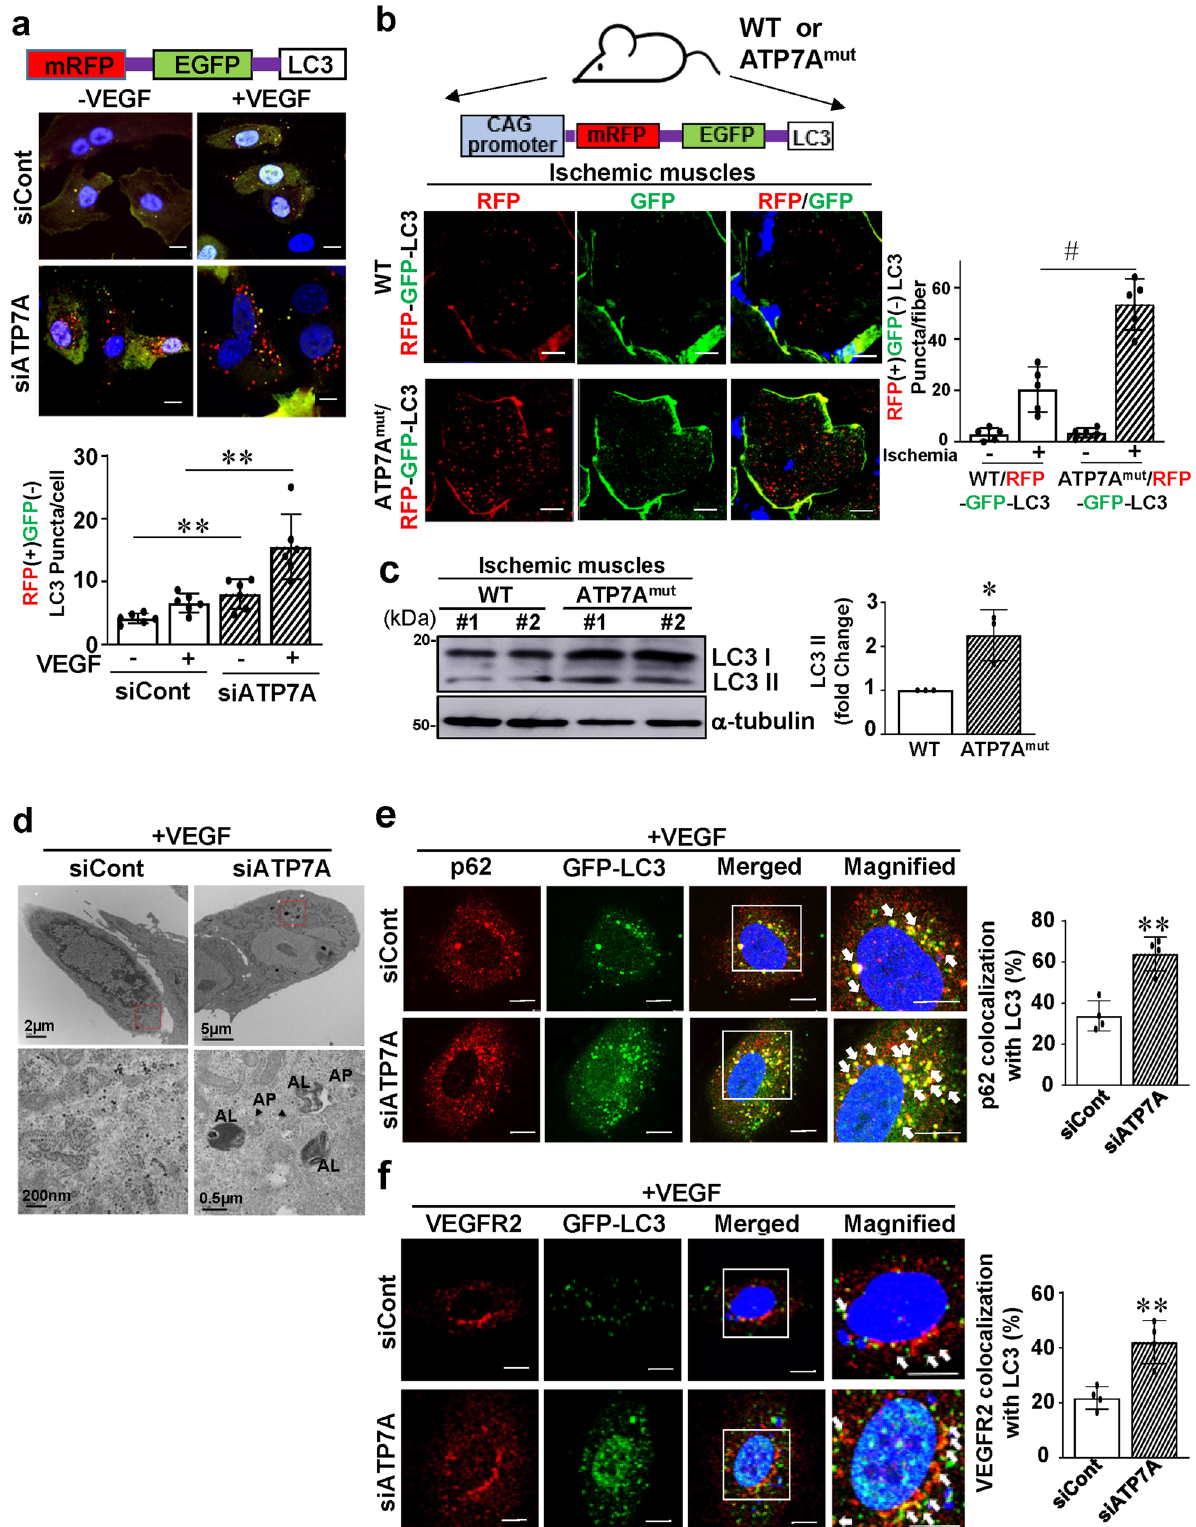
Methods Animals . The use of mice was in accordance with the National Institutes of Health Guide for the Care and Use of Laboratory Animals and relevant ethical regulations. Mouse experiments were approved by the Institutional Animal Care and Use Committee of Augusta University. To generate EC-speci fi c ATP7A KO mice, we fi rst generated an ATP7A fl oxed mouse line using ATP7A fl oxed ES cells obtained from European Conditional Mouse Mutagenesis Program (EUCOMM). We NATURE COMMUNICATIONS| (2021) 12:3091